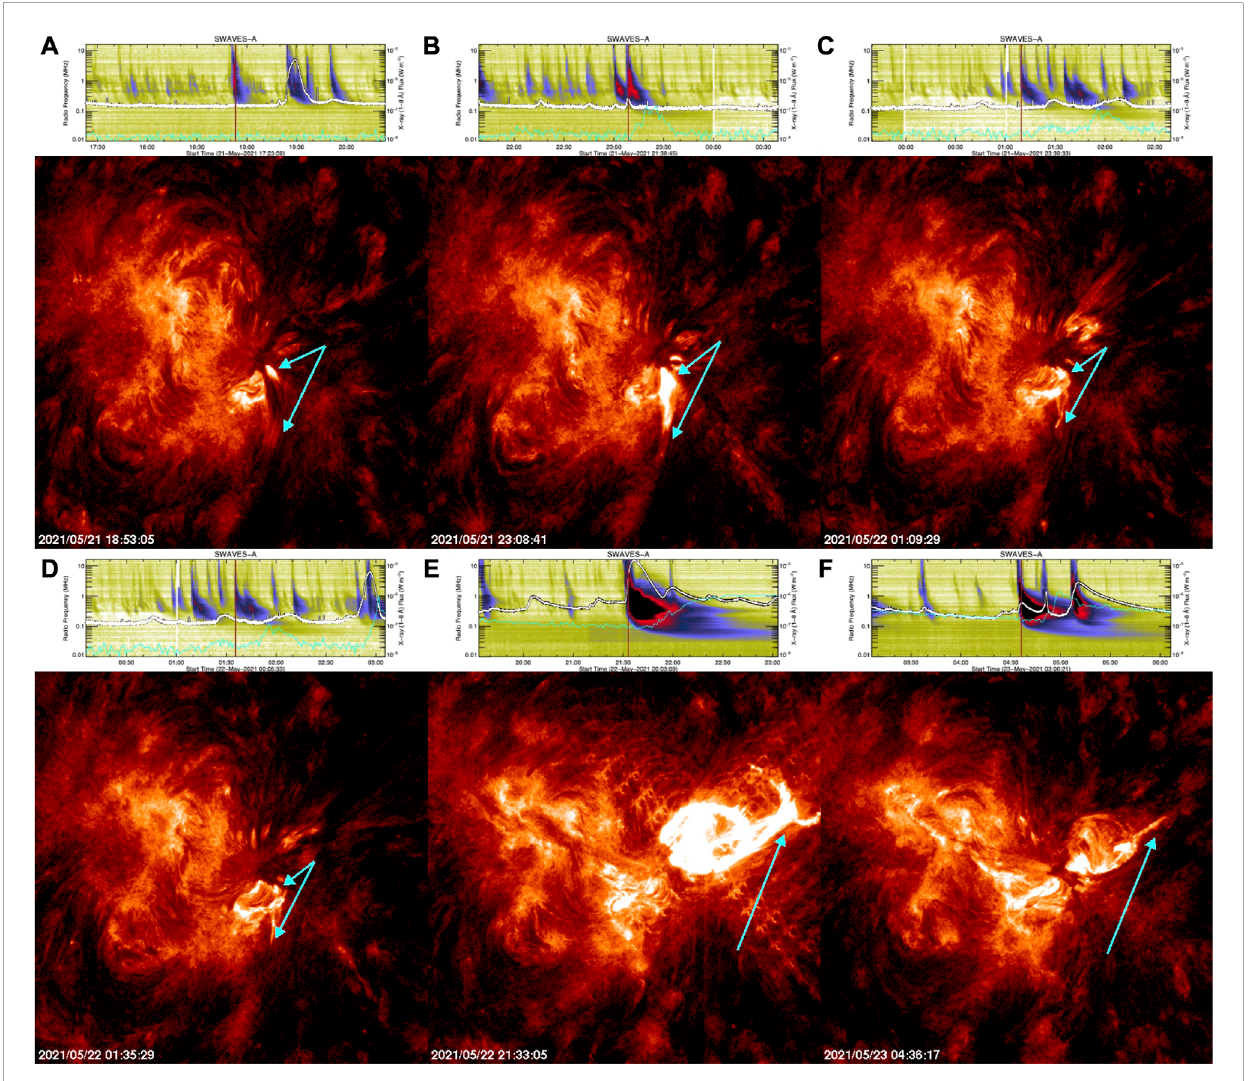
FIGURE 7 Jet-like eruptions around the times of type III bursts. In (A–D) , two arrows point to the footpoint and spire. In (E,F) , the arrow points to the spire or the upper part of the ejections. These eruptions likely contributed to the six 3 He-rich SEP